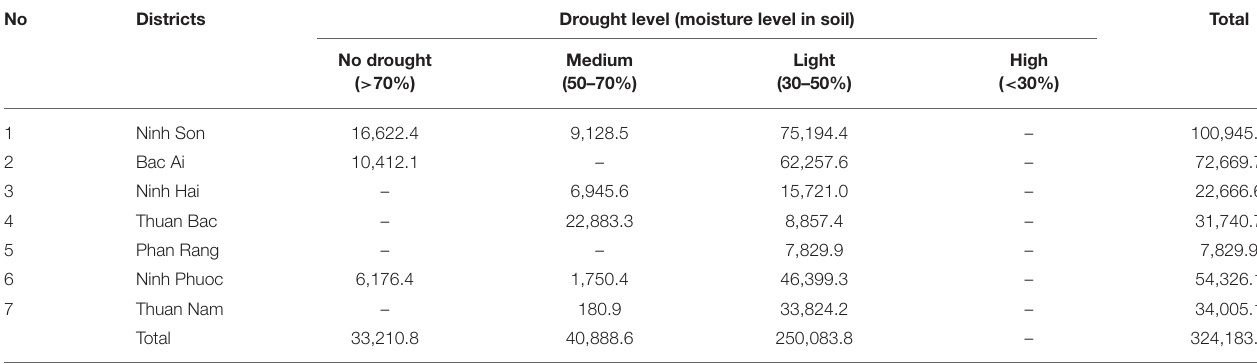
TABLE 1 | Area of meteorological drought by degree of Ninh Thuan province in 2020 (hectare).